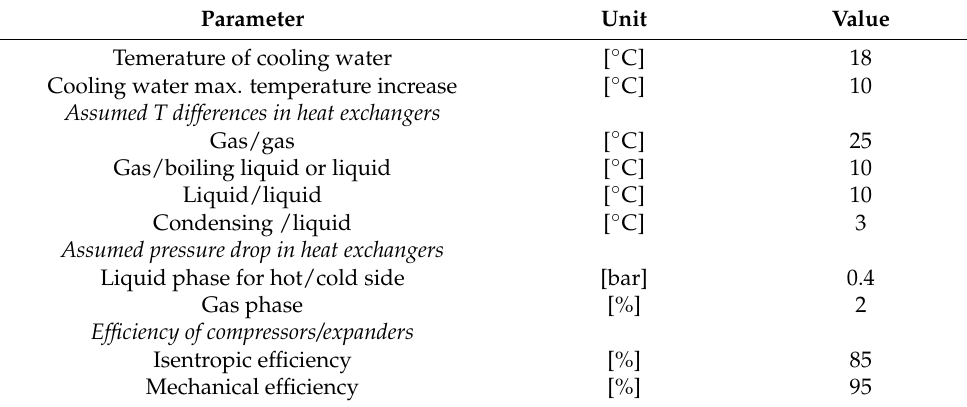
Plus . A schematic overview of the model is given in Figure 5.